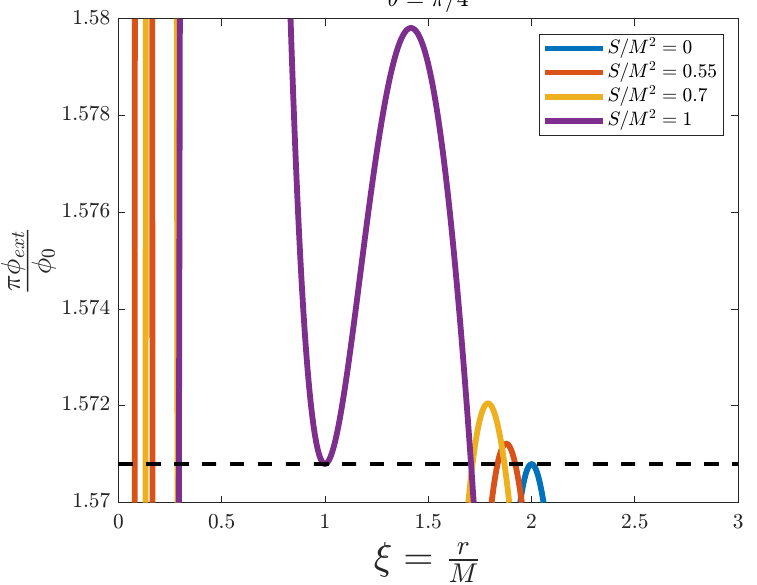
Figure 6. A zoom-in of Figure 5, where the regions with πφ ext / φ 0 above the threshold value π /2 (dashed line) can be better